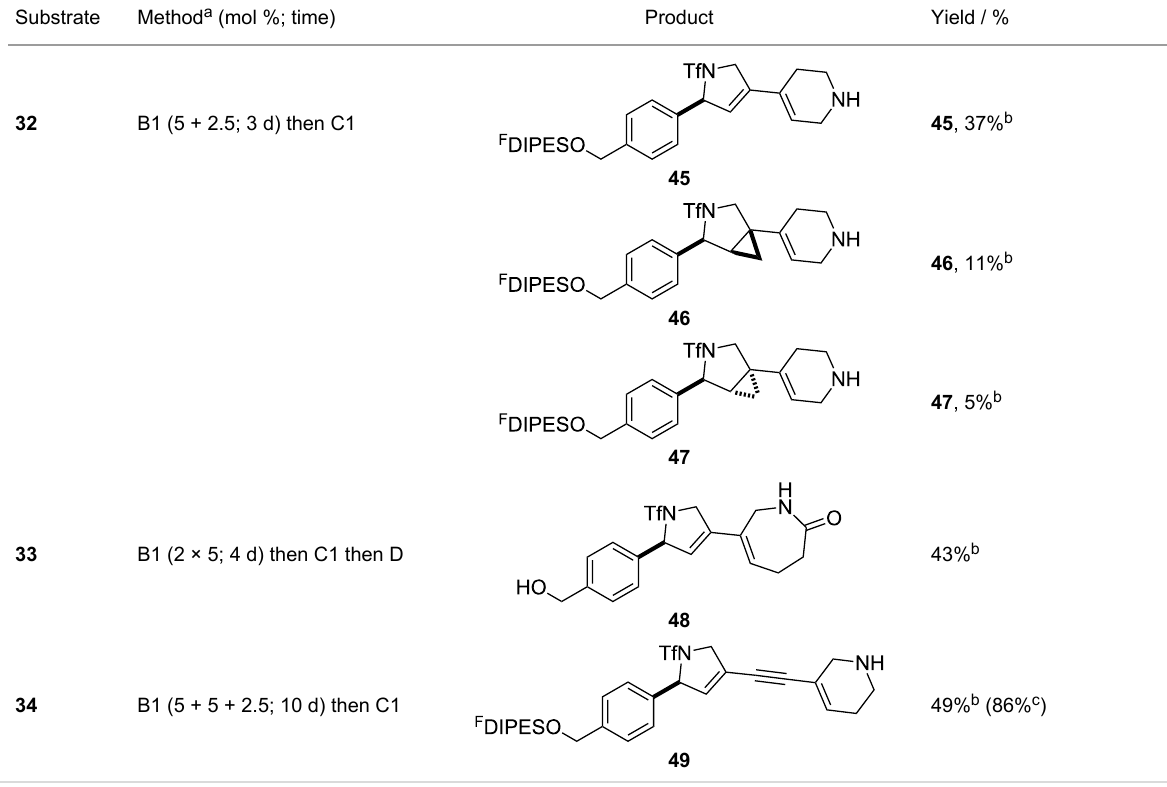
Table 3: Application of cascade metathesis reactions in the synthesis of diverse scaffolds and subsequent desulfonylation.